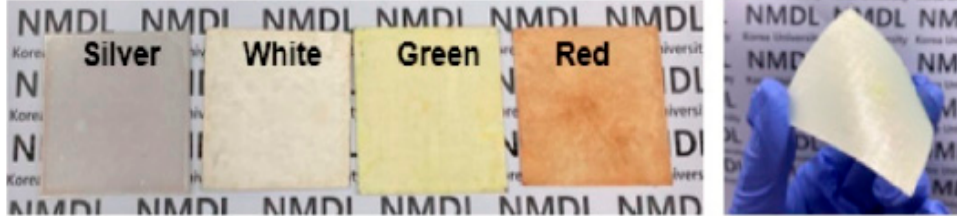
Figure 33. White, green, and red colored DPRC emitter for sub-ambient cooling [161].